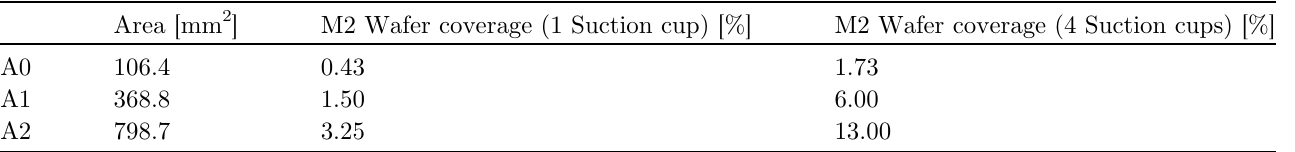
Fig. 7. Image section of a PL image of a wafer handled before passivation with marked different sized areas, used for the local loss analysis. Table 1. Values for the different sized areas in Figure 12 and their percentage size fraction on a M2 wafer for one and four